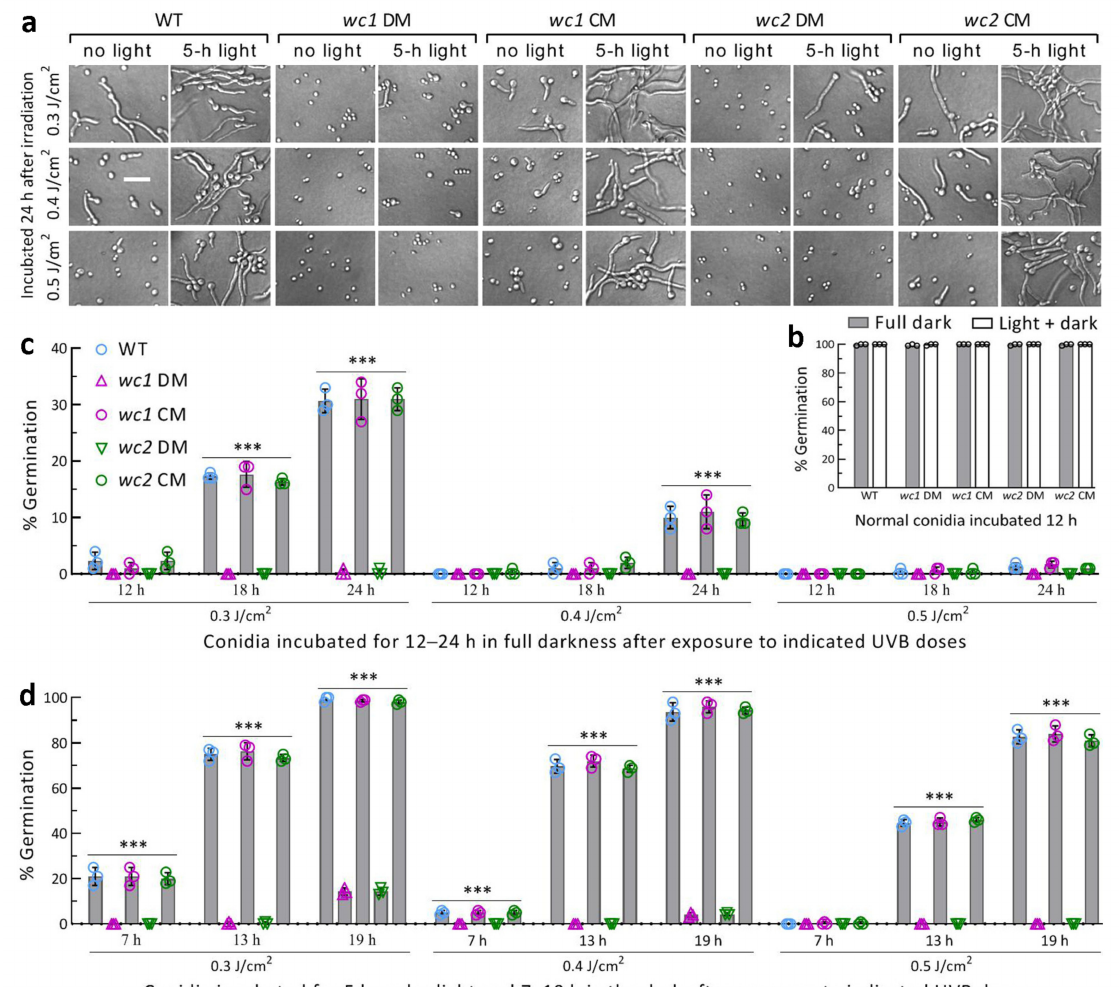
Figure 2. Essential versus infeasible roles of WC1 and WC2 in photoreactivation versus dark re- activation of UVB-impaired B. bassiana conidia. ( a ) Microscopic images (scale: 20 µ m) for conidial germination status of disruption mutants (DM) and control (CM and WT) strains incubated at 25 ◦ C for 5 h under white light plus 19 h in the dark (photoreactivation),or directly for 24 h in the dark (NER) after irradiation at the indicated UVB doses. ( b ) Germination percentages of normal conidia incubated at 25 ◦ C for 5 h under the light plus 7 h in the dark and directly for 12 h in the dark. ( c , d ) Germination percentages of irradiated conidia reactivated using 12, 18, and 24 h of full dark incubation and the incubation of 5 h light plus 7, 13, and 19 h in the dark at 25 ◦ C, respectively. *** p < 0.0001 in Tukey’s test. Error bars: SDs of the means from three independent replicates. The reactivated percentage of the control strains’ conidia was dependent on the UVB dose and incubation time post-irradiation. In the full dark treatment, the control strains’ conidia impaired at 0.3 J/cm 2 were on average reactivated by 2% ( ± 1.4), 17% ( ± 1.4), and 30% ( ± 2.3) ( n = 9) at the end of 12, 18, and 24 h incubation, respectively (Figure 2c). When the UVB dose increased to 0.4 and 0.5 J/cm 2 , the reactivated percentage of the